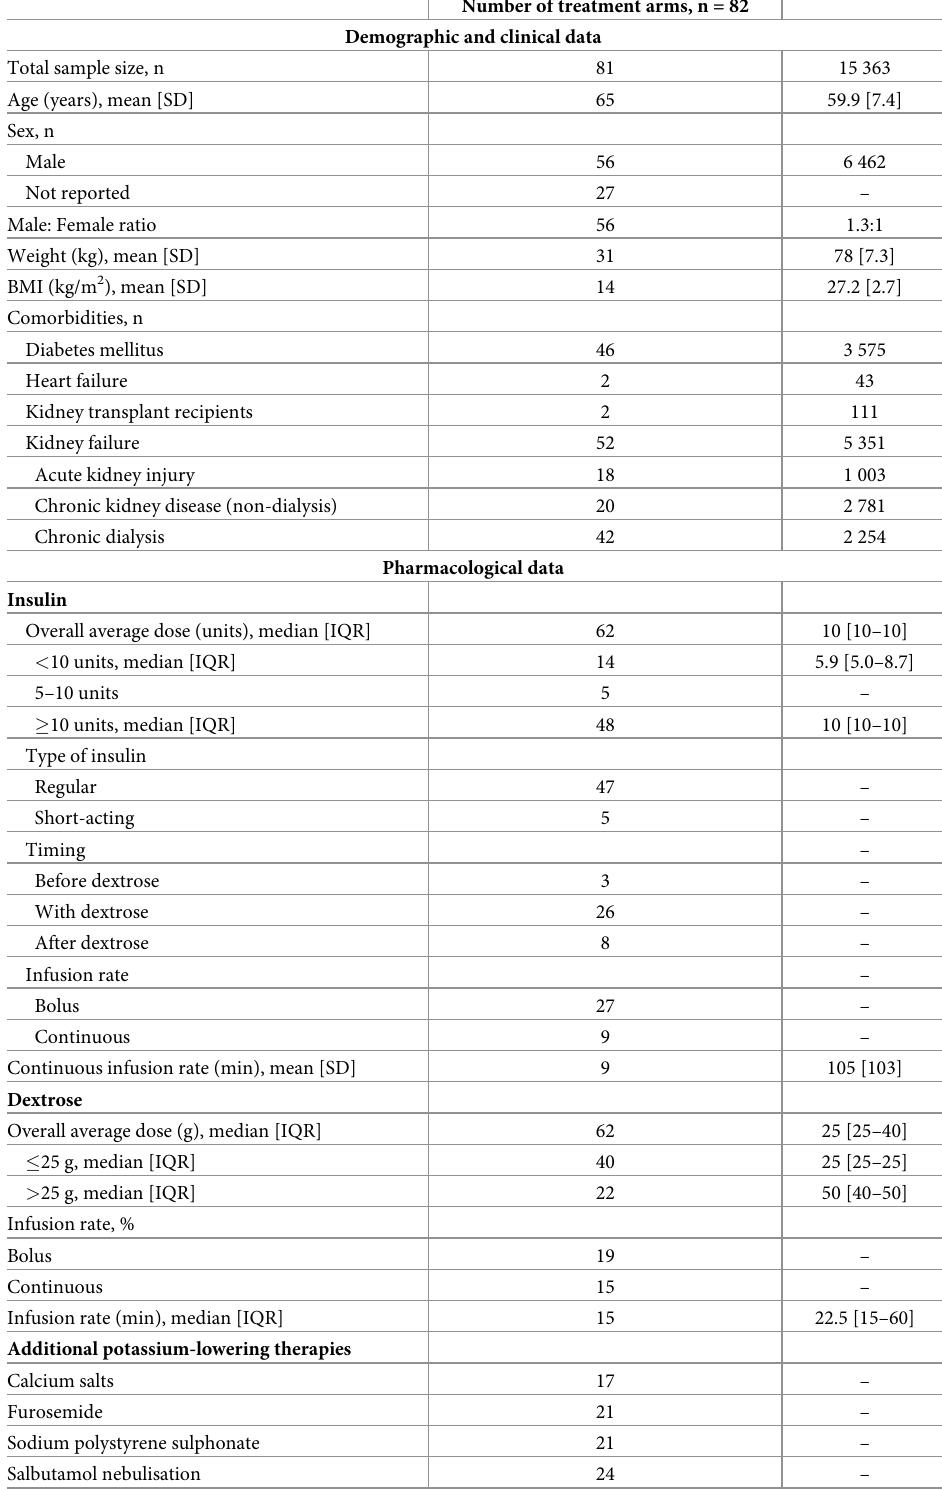
Table 2. Summary of demographic, clinical and pharmacological data for primary included